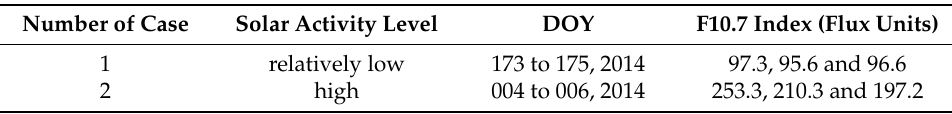
Table 3. The information of the two cases in the